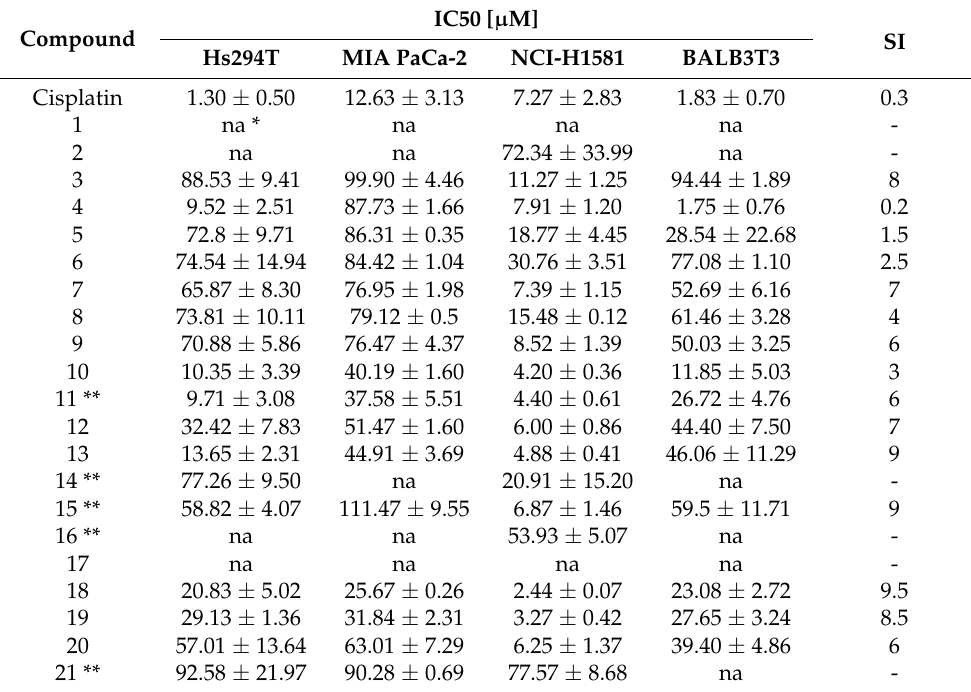
Table 1. Antiproliferative activity of triazoles 1–21 .